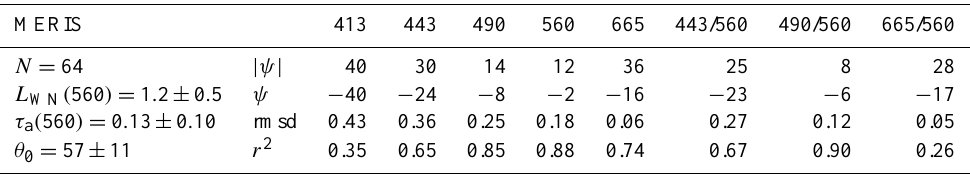
Table 4. Statistical results from the analysis of MERIS (3rd Reprocessing) and AERONET-OC L WN , and their ratios at specific center wavelengths for the match-ups determined at AAOT with 1t = ± 1h. The analysis has been restricted to the 64 match-ups common to both the 2nd and 3rd Reprocessing. Symbols and units are the same as in Table 1.